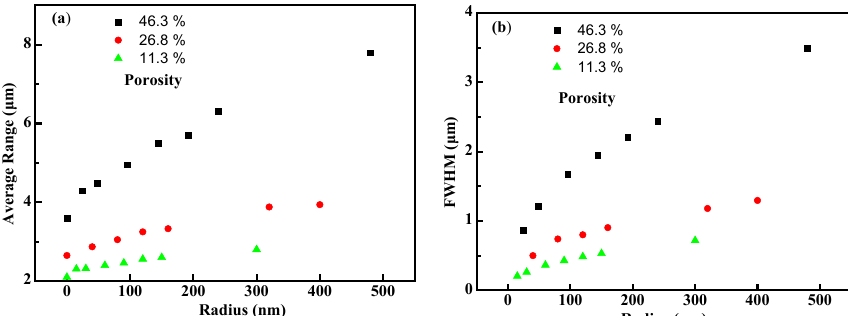
Figure 8. ( a ) The relationship between proton range and radius of voids (when the porosity was kept at 46.3%, the radius was set as 24, 48, 96, 144, 192, 240 and 480 nm, respectively; when the porosity was kept at 26.8%, the radius was set as 40, 80, 120, 160, 320 and 400 nm, respectively; when the porosity was kept at 11.3%, the radius was set as 15, 30, 60, 90, 120, 150 and 300 nm, respectively); ( b ) the relationship between FWHM and radius of voids.